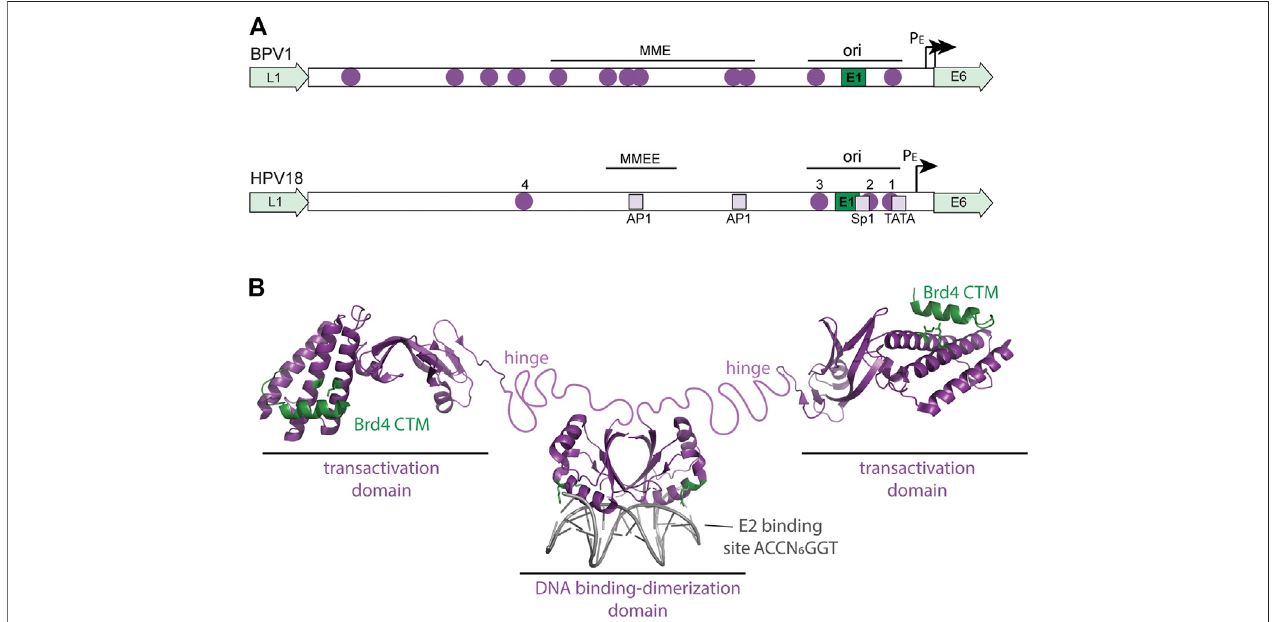
FIGURE 3 | Regulatory elements in the viral URR and structure of the HPV E2 protein. (A) The diagram shows a comparison of the BPV1 and HPV18 Upstream Regulatory Regions (URR). Both URRs contain the replication origin (with E1 and E2 binding sites) as well as the additional E2 sites shown (purple circles). In BPV1, the Minichromosome Maintenance Element (MME) is required for maintenance replication and genome partitioning. In HPV18, a region named the Minichromosome MaintenanceEnhancerElement(MMEE)isrequiredformaintenancereplication.InHPV18,E2bindingsites#1and#2overlapbindingsitesforSp1andTBP(TATA) in the early promoter and thus E2 binding represses transcription. AP1 sites in the URR are important for both transcription and replication of the HPV genome. These cellular binding sites are indicated by light purple squares. Ori: origin of replication; P E : Early Promoter. (B) The structure ofthe HPV E2-TA protein is shown. The HPV16 transactivation domain is shown bound to the Brd4 CTM peptide (residues 1,343 – 1,362 in green) from the pdb fi le 2NNU. The E2 residues important for this interaction (R37 and I73) are shown in green. The dimeric HPV18 DNA binding domain bound to an E2 binding site is from the pdb fi le 1JJ4. E2 Residues that contact the Brd4 N-terminal regions (R307 and K308) are highlighted in green. An unstructured, fl exible linker connects the E2 domains and is named the